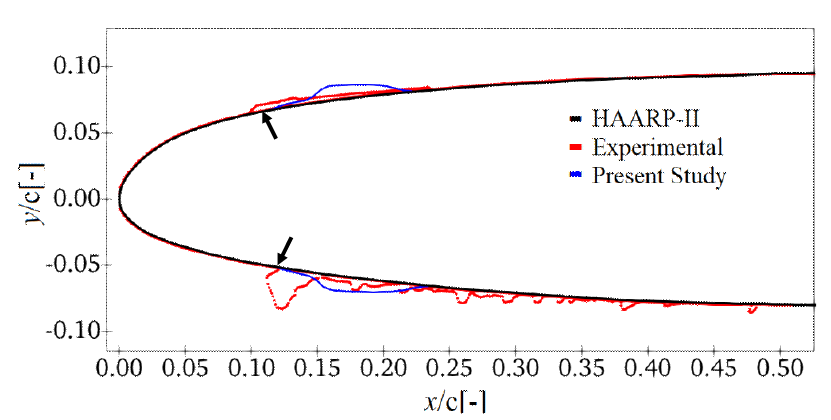
Figure 4. Ice shape for HAARP-II with experiment the by Papadaikis et al. [35]. Red and blue lines represent experimental and the present results, respectively. Arrows represent the icing starting location.